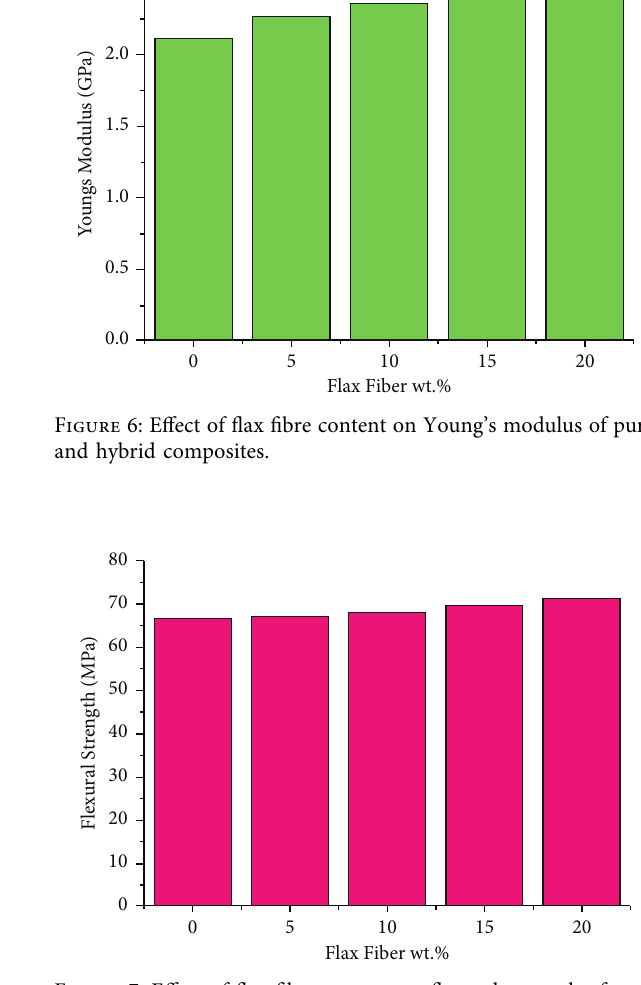
Figure 7: Effect of flax fibre content on flexural strength of pure and hybrid composites.